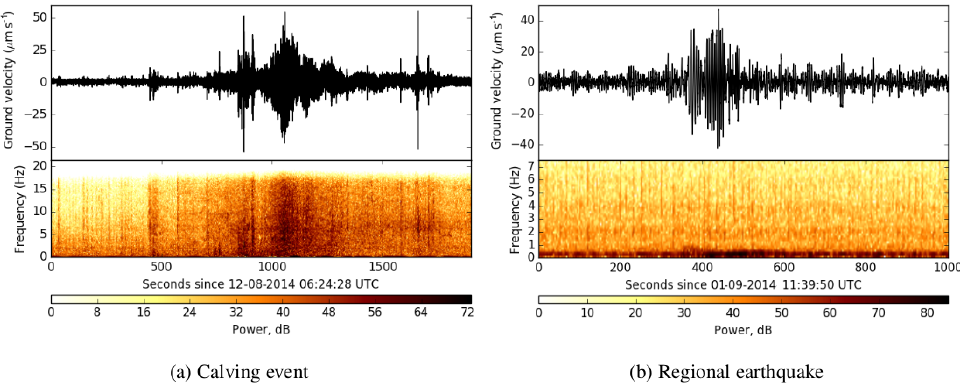
Figure 2. Spectrograms for (a) a calving event at Helheim on 12 August 2014, and (b) a regional earthquake in Bárðarbunga, Iceland on 1 September 2014. The easting amplitude of the seismometers is used for both events. The seismogram (top) and spectrogram (bottom) of each event share the same time axis for direct comparison. The spectrograms have a window size of 256 points ( = 6 . 4s).